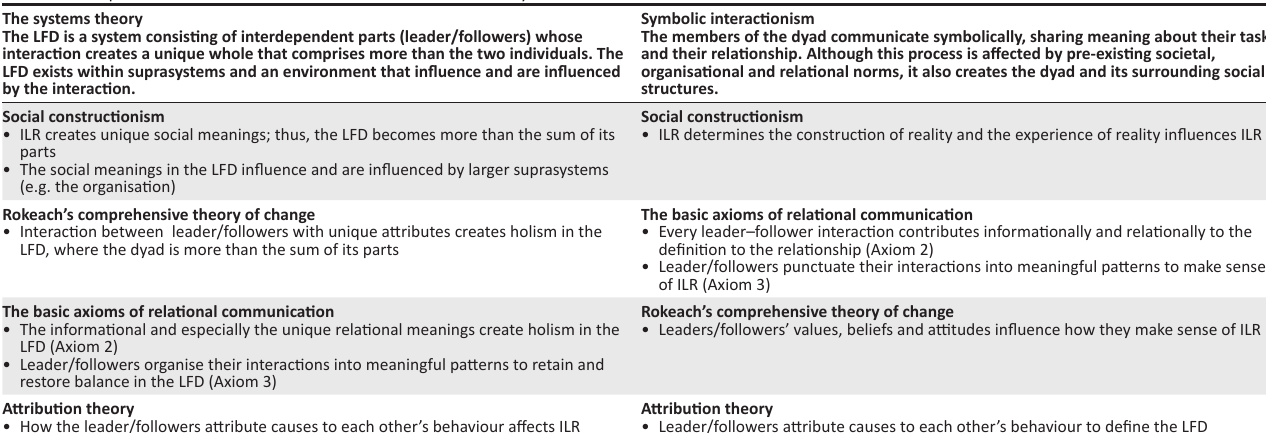
TABLE 2: Interpersonal communication theories relevant to this